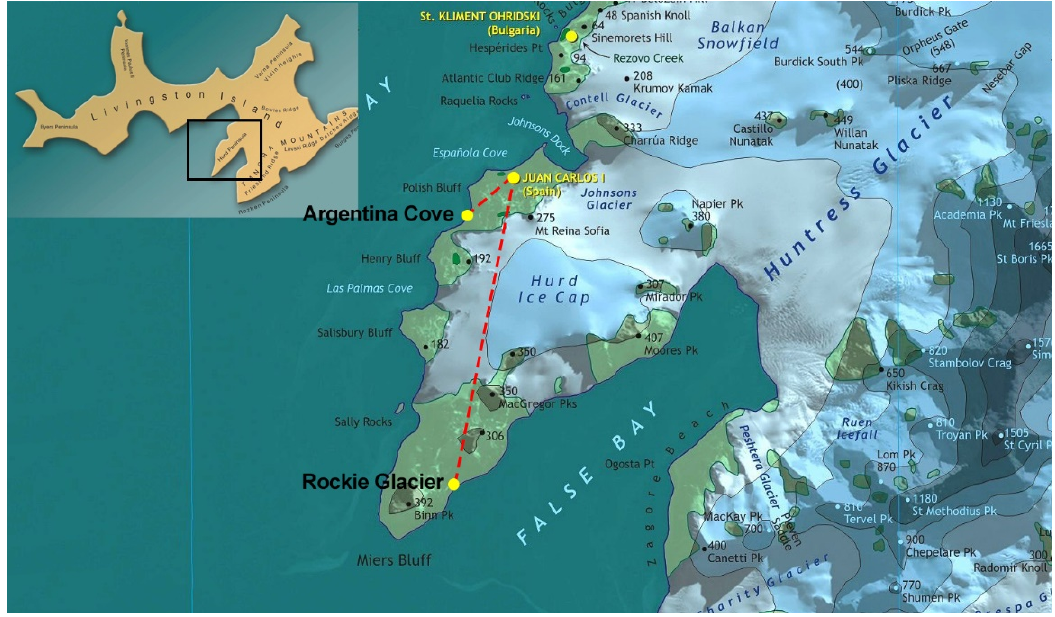
Figure 1. Locations of the points for channel sounding: Argentina Cove and Rockie Glacier.